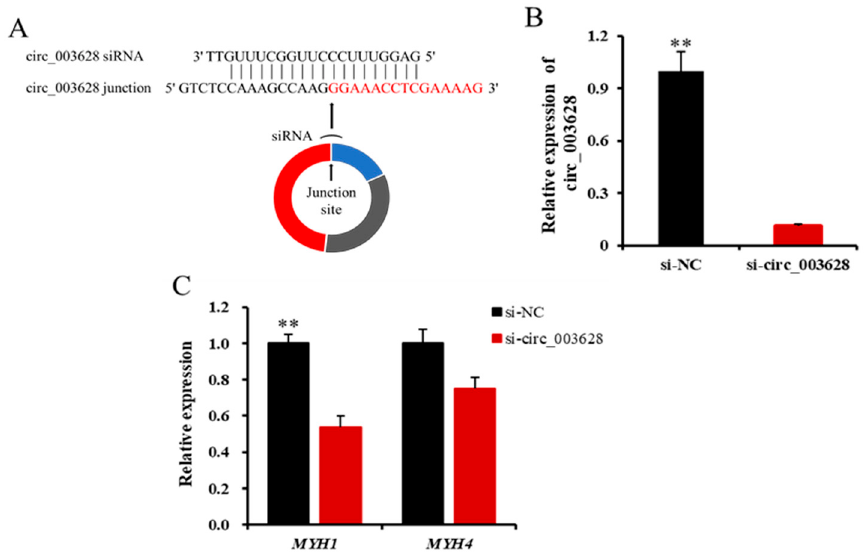
Figure 5. Schematic diagram of si-circ_003628 sequence specifically targeted the junction site of circ_003628 ( A ) and effect of si-circ_003628 on expression levels of circ_003628 ( B ) and its parent genes MYH1 and MYH4 ( C ) when si-circ_003628 was transfected into SMSCs. ** p < 0.01. The CCK-8 assay revealed that si-circ_003628 remarkably reduced the viability of SMSCs ( p < 0.01, Figure